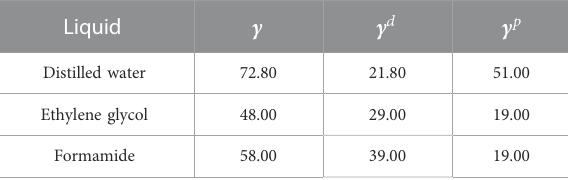
TABLE 9 Test design and